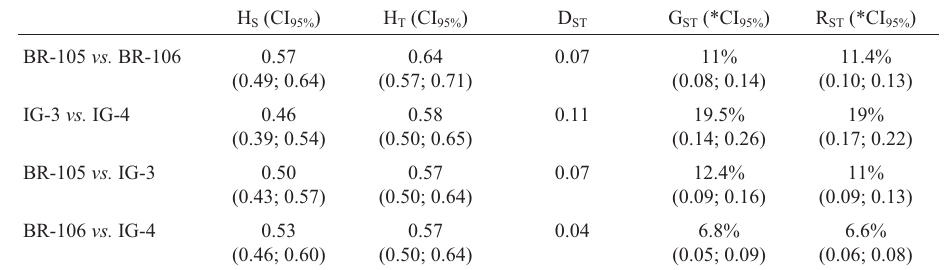
*Bootstrap with 10.000 replicates.